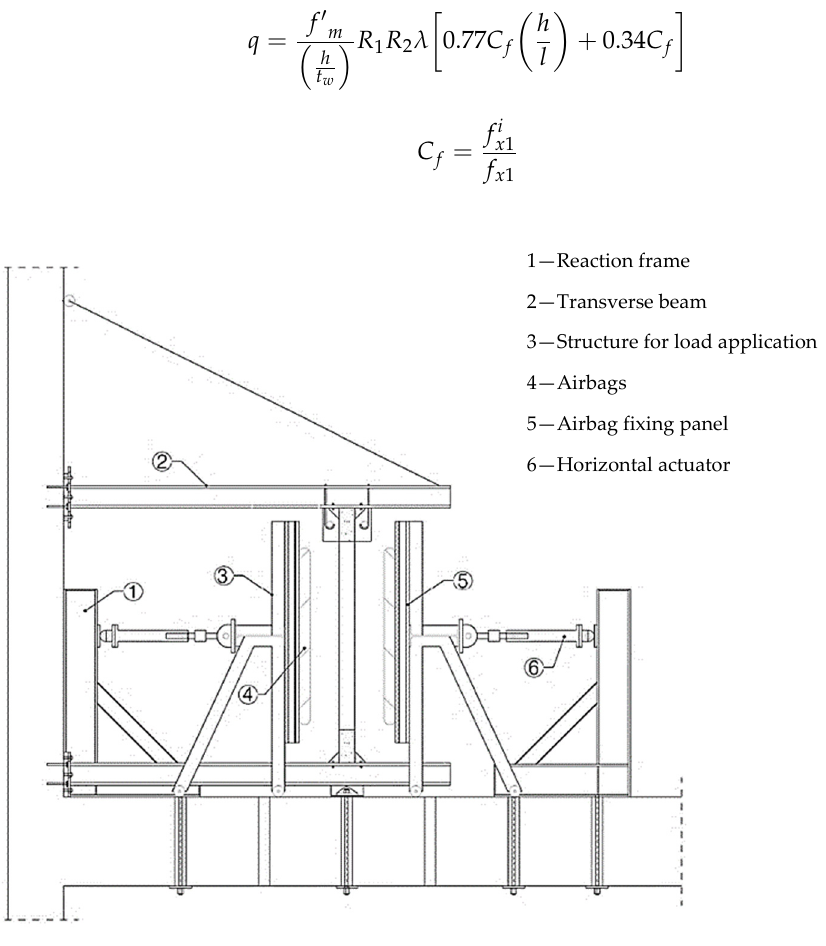
Figure 5. Out-of-plane test setup [15].